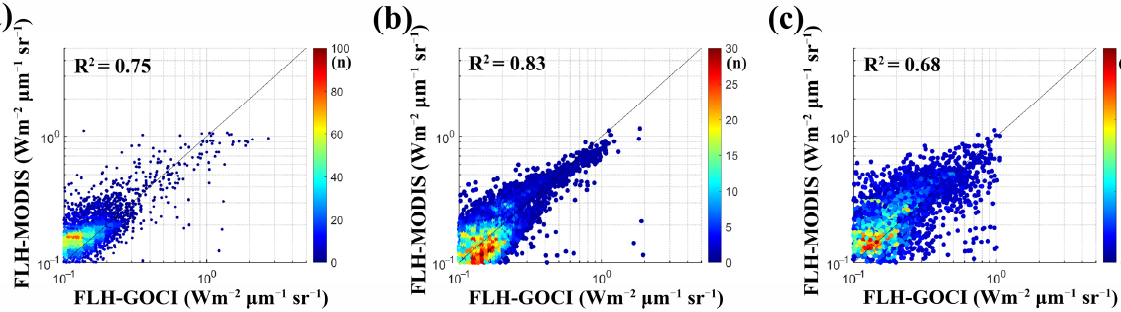
Figure 10. Density scatter plots between GOCI and MODIS FLH products using the improved algorithms. ( a ) 18 October 2011, ( b ) 27 April 2012, and ( c ) 7 December 2013.